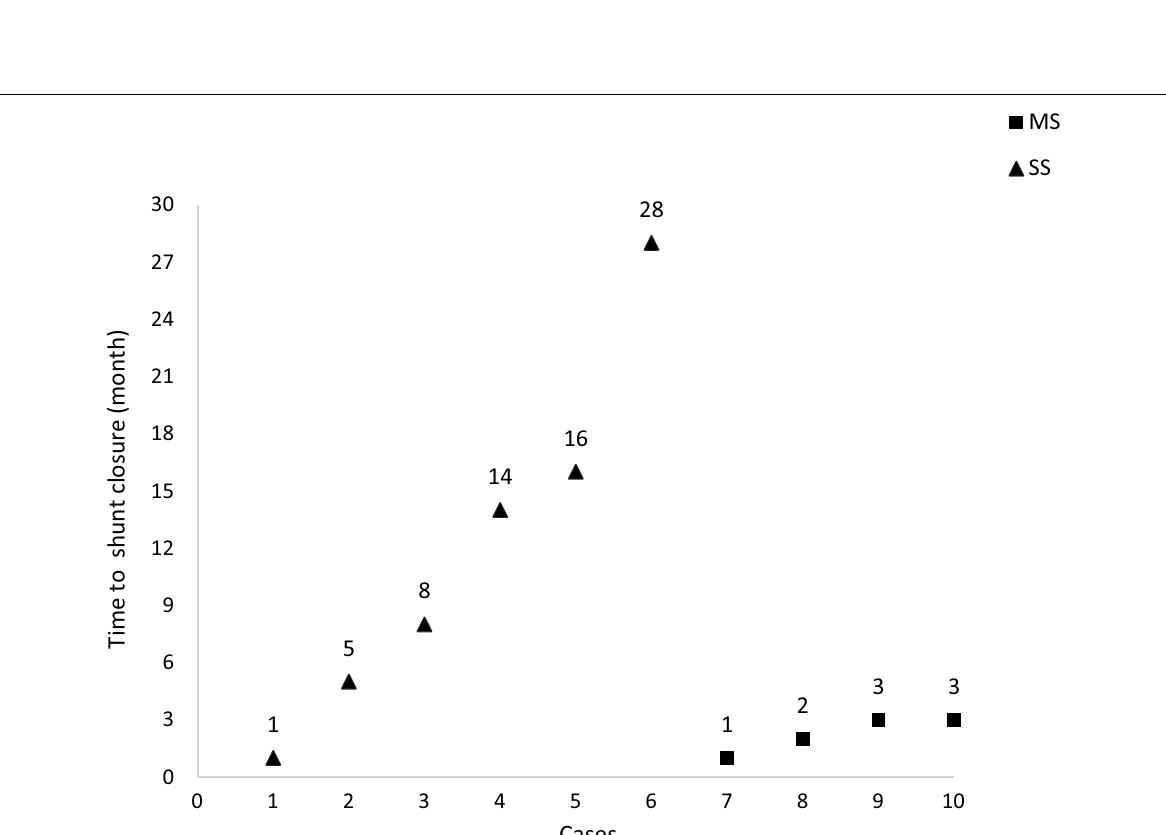
The origin posi(cid:31)on of the shunts were from only the RPV Fig. 2 In the single-shunt group, the origin position of the shunts was all from the LPV. In the multiple-shunt group, the origin position of the shunts was from the LPV in six cases, and both the LPV and RPV in one case. There was no case that the origin position of the shunts was from only the RPV. SS: single shunt; MS: multiple shunts; LPV: left portal vein; RPV: right portal vein